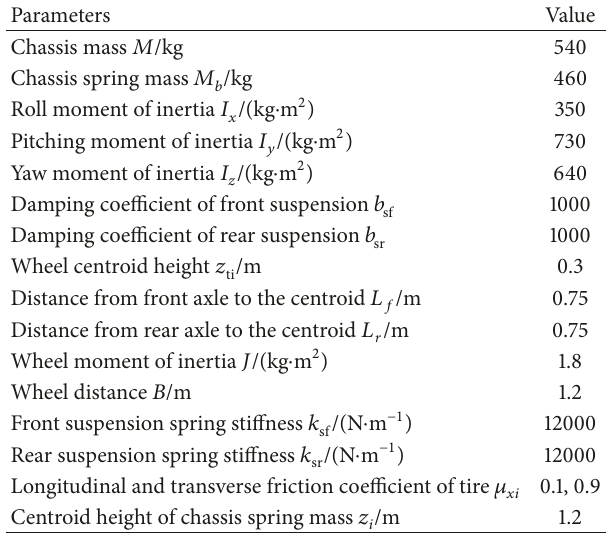
Table 1: Simulation parameters of straight line drive coordinated control of sprayer